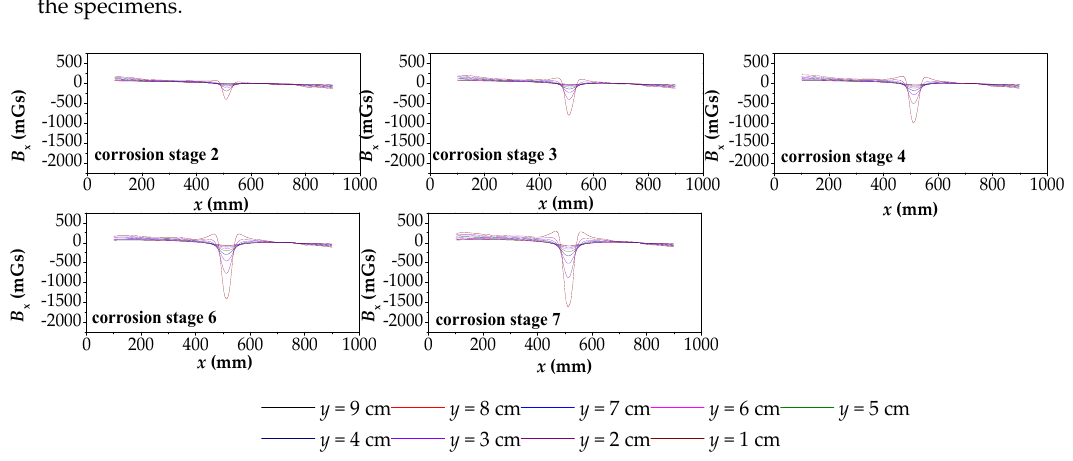
Figure A2. The B x curves of P2 under residual corrosion stages. P2: the parallel wire strand made of 19 steel wires; B x : the magnetic flux component of x direction; x : the coordinate along the length of the specimens.